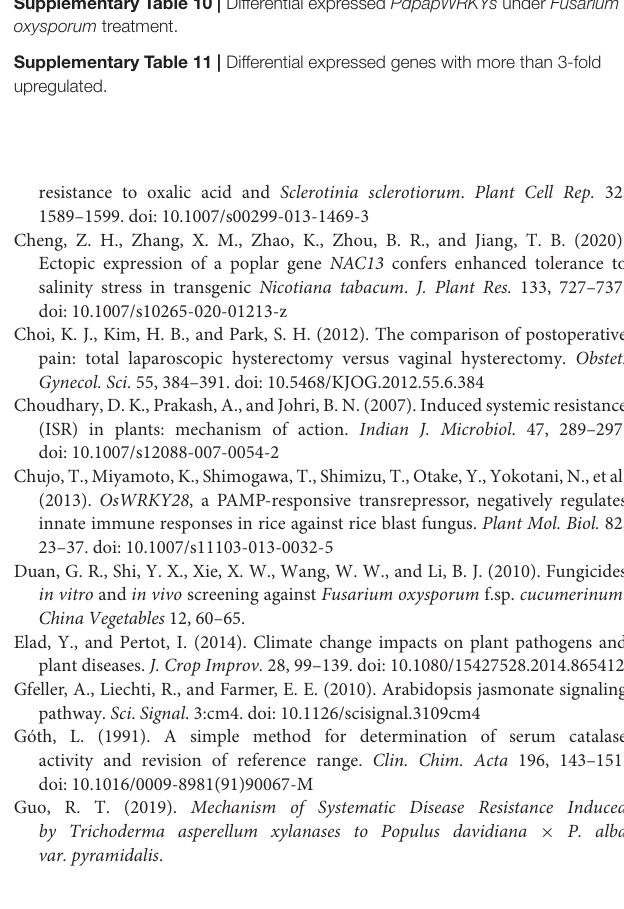
Supplementary Table 8 | Differential expression gene statistics.